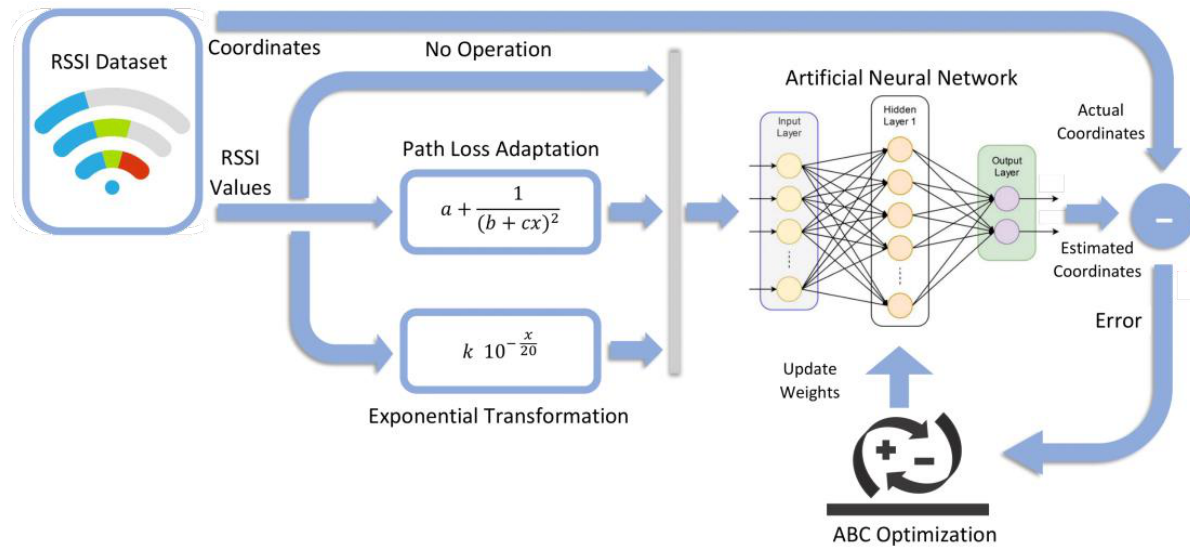
Figure 1. The general concept of the study.